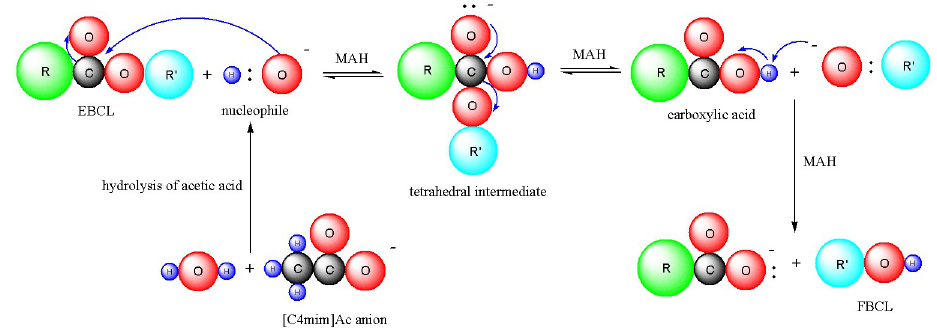
Fig 4. Mechanism of EBCL hydrolysis into FBCLs in [C4mim]Ac solution during MAH.